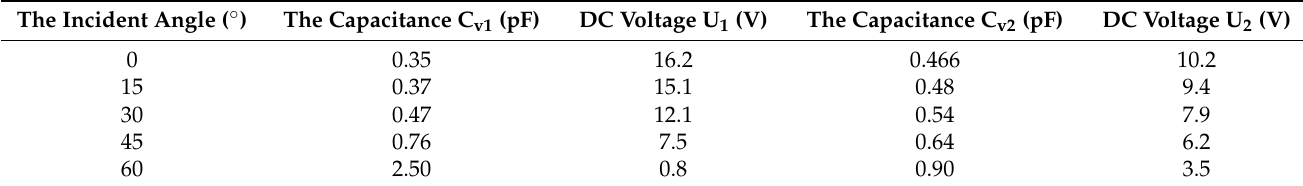
Table 2. The measurement parameters for achieving angular non-dispersion.